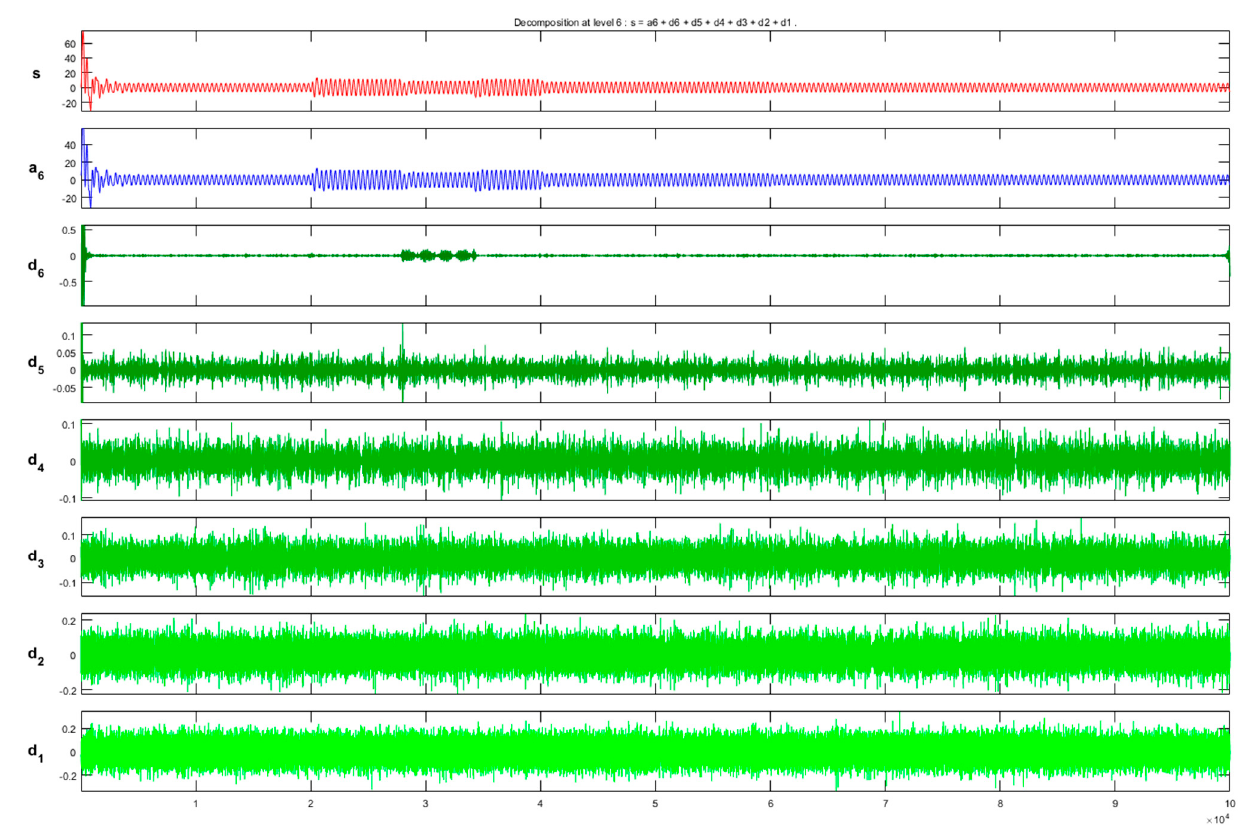
Figure 8. Reconstructed W–N signals using DWT.